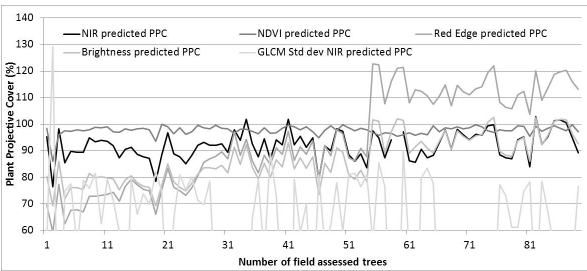
Figure 6. Estimated PPC of the 89 pre-pruned tree crowns for which PPC was measured post-pruning. PPC for the pre-pruned tree crowns was estimated using the best-fit equations based on the post-pruned image and field data.